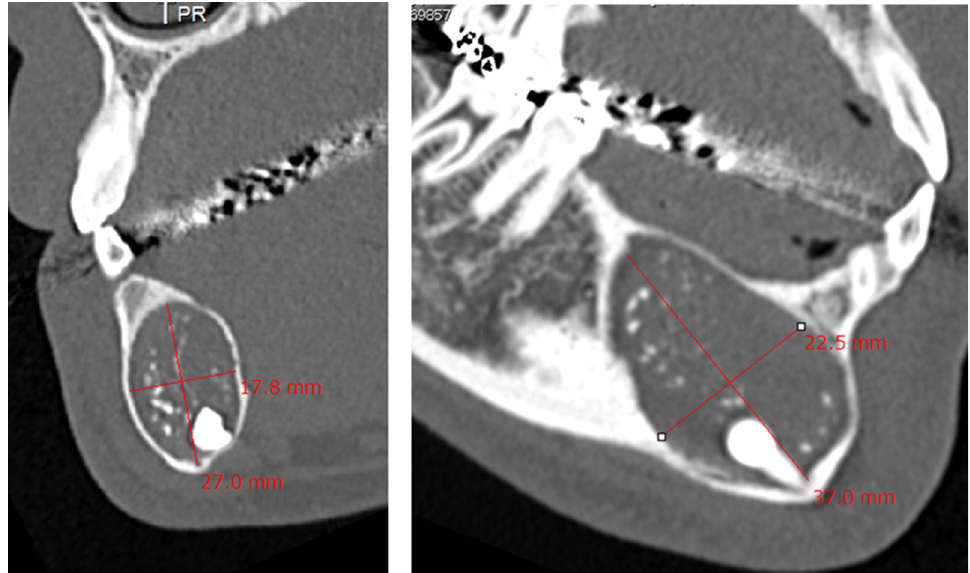
Fig. 3. Computed tomography (CT) imaging demonstrated a large expansive lesion contained multiple and minimal fl ecks of high density. The dimensions of the lesion measured 37.0 m (cid:3) 27.0 mm (cid:3) 17.8mm.